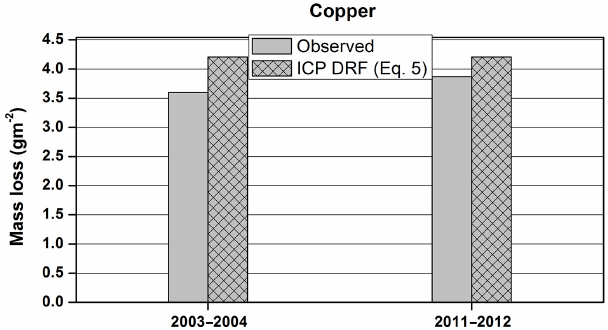
Figure 7. Experimental obtained mass loss values at Athens, Greece for the case of copper along with the predicted values by ICP DRF.